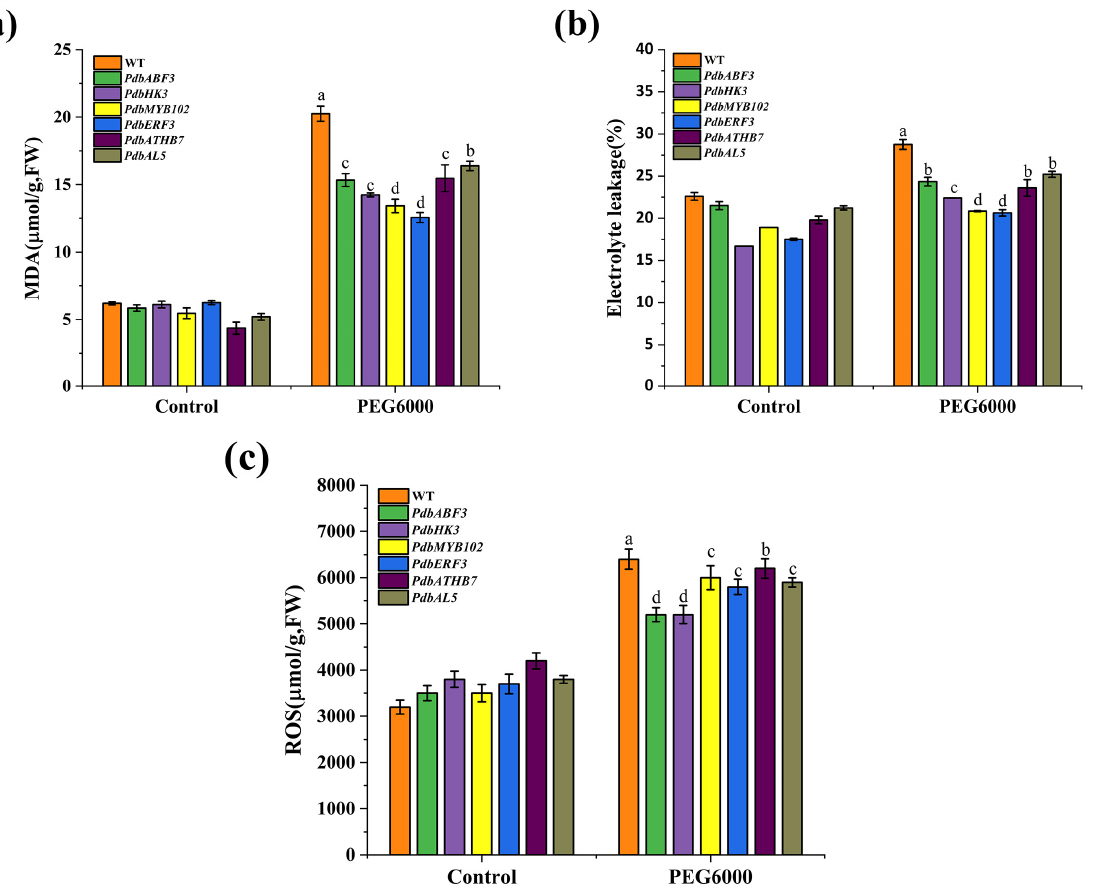
Figure 4. Determination of drought tolerance properties of the first-layer regulators of the GRN ( a ) MDA content analysis; ( b ) electrolyte leakage assay; ( c ) ROS content analysis. The genes were transiently transformed into P. davidiana × P. bolleana plants for overexpression; the plants transiently transformed with empty vector were used as controls. At 48 h after transformation, the plants were watered with 20% PEG6000 solution on roots for 24 h. The data with different letters indicate significant differences ( p < 0.05). As the transformations were performed in different batches, each batch had an independent control. The gene names and GenBank numbers are PdbERF3 (GenBank